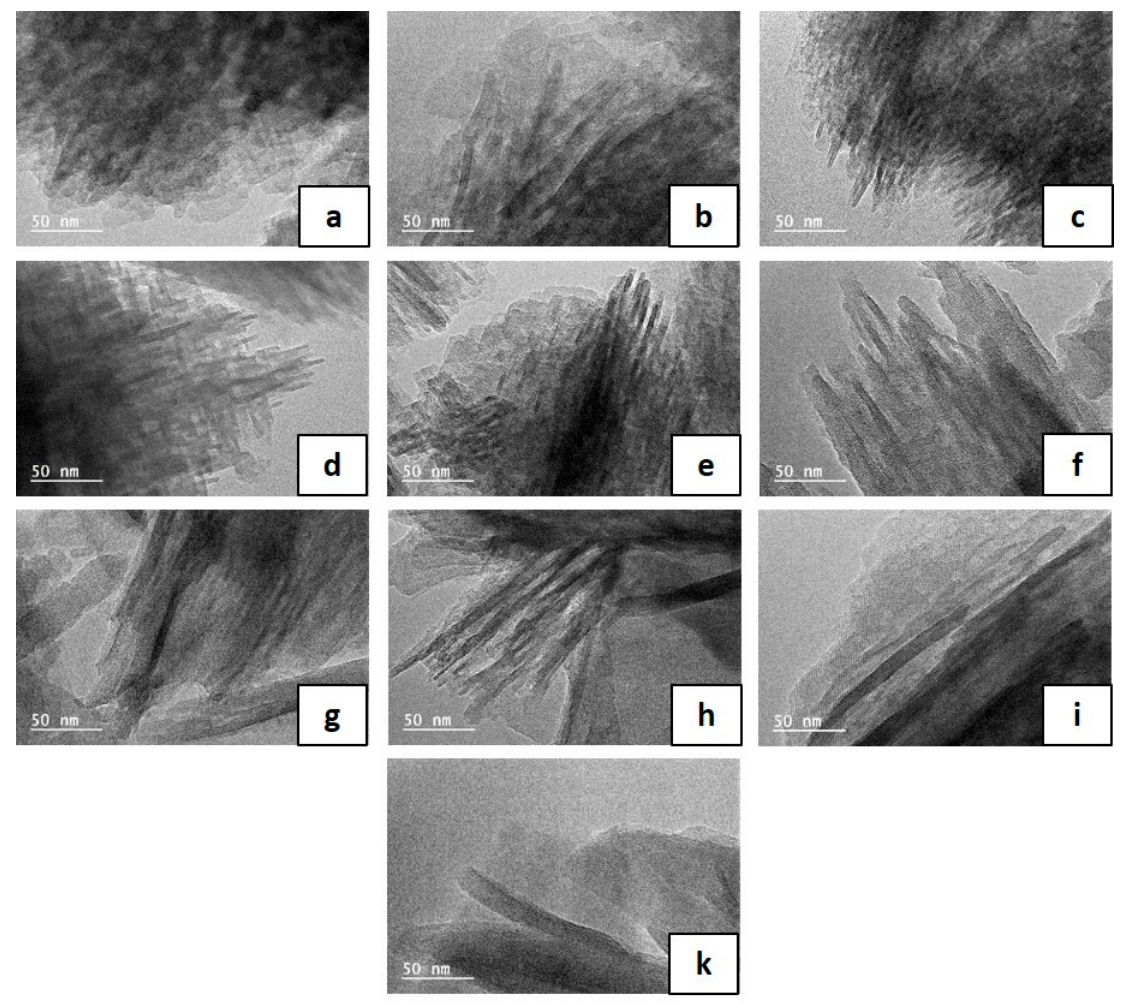
Figure 3. Transmission electron microscopy (TEM) images of silicalite ‐ 1 beads as a function of their temperature and duration synthesis (B ‐ T(°C) ‐ t(days)): ( a ) B110 ‐ 2, ( b ) B110 ‐ 3, ( c ) B110 ‐ 5, ( d ) B130 ‐ 2, ( e )